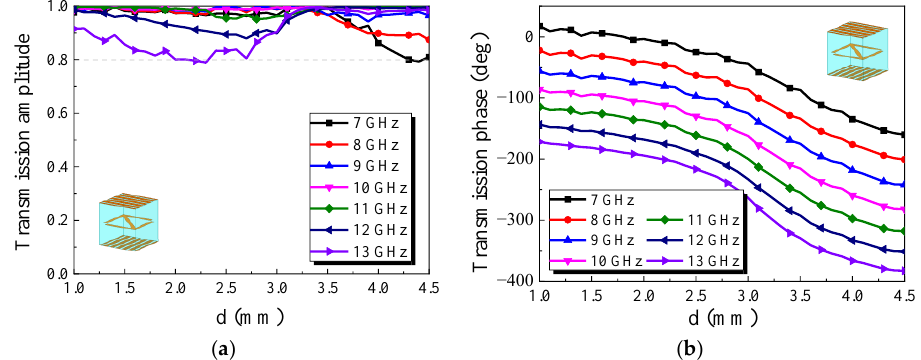
Figure 2. Electric field vector distribution on the central axis at 10 GHz.